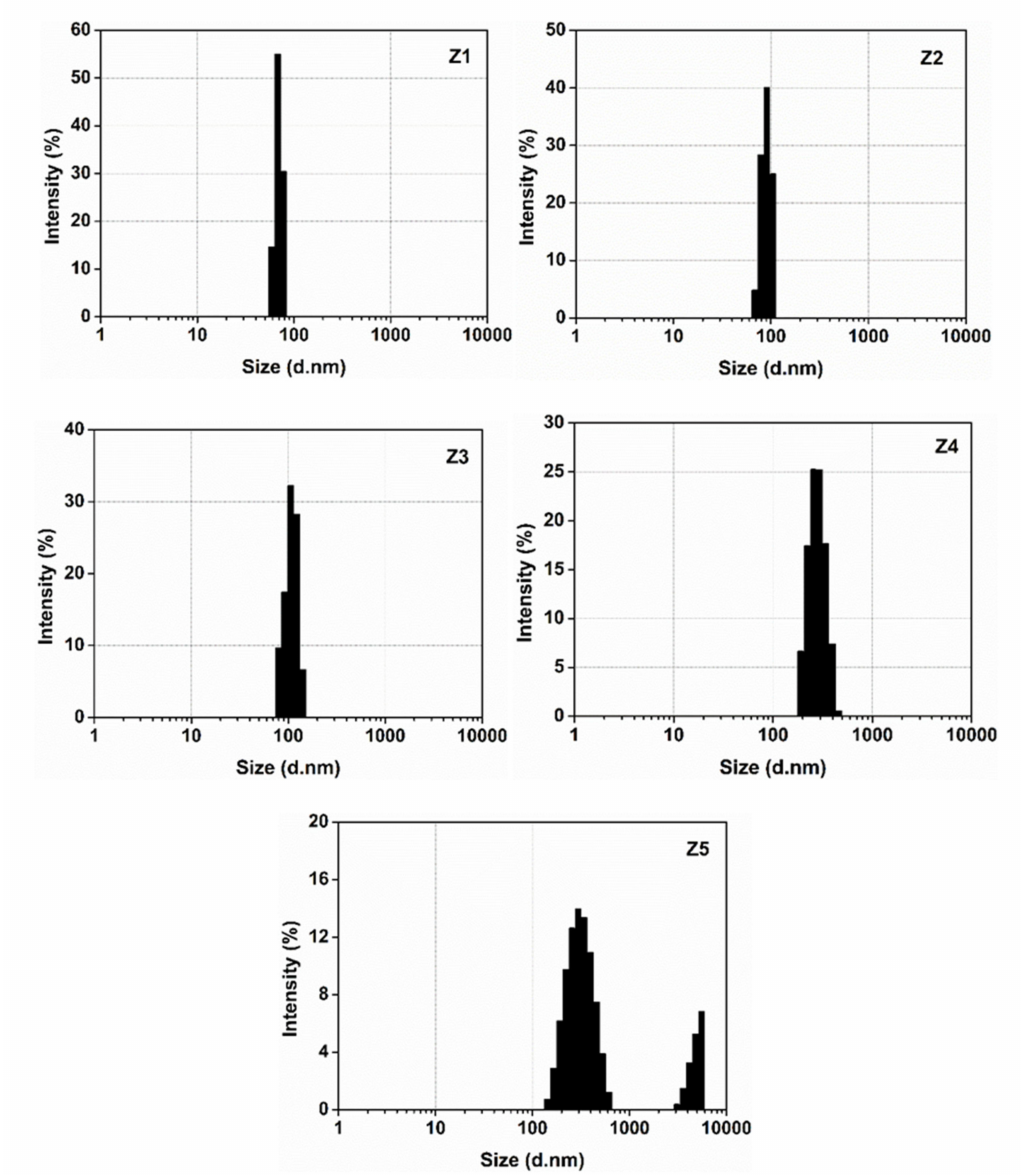
Figure 4. Z1, Z2, Z3, Z4, and Z5 composite-hardened sol liquid particle size distribution